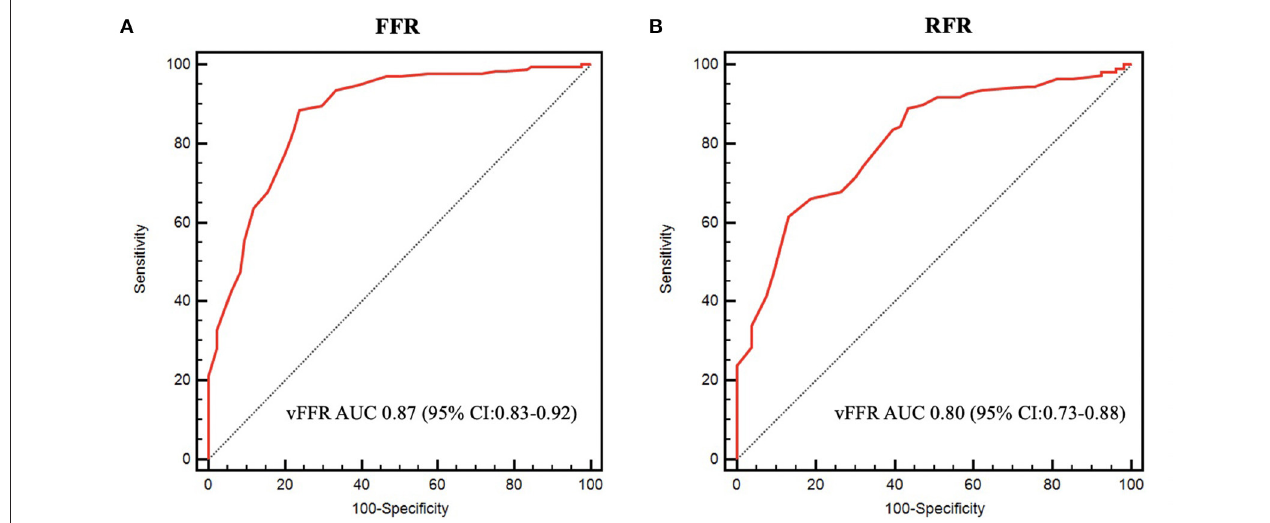
FIGURE 6 | Receiver operating characteristic curves. (A) ROC curve of vFFR for FFR ≤ 0.80. (B) ROC curve of vFFR for RFR ≤